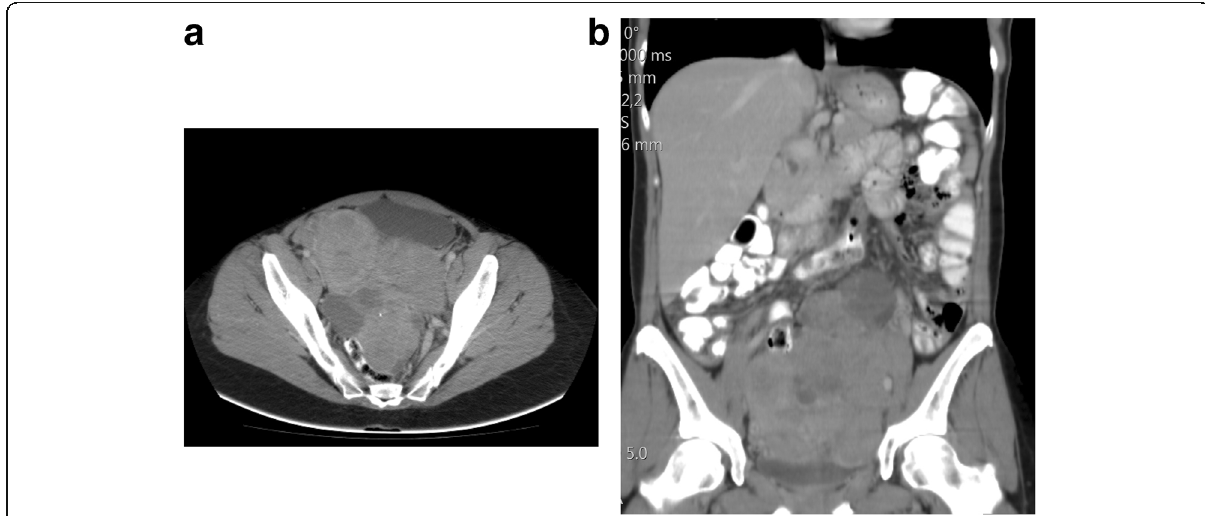
Fig. 6 Axial (left) and Coronal (right) CT post-contrast image of the abdomen and pelvis showing heterogeneously enhancing solid mass, corresponding to a primary HGSC of a BRCA 2 mutated